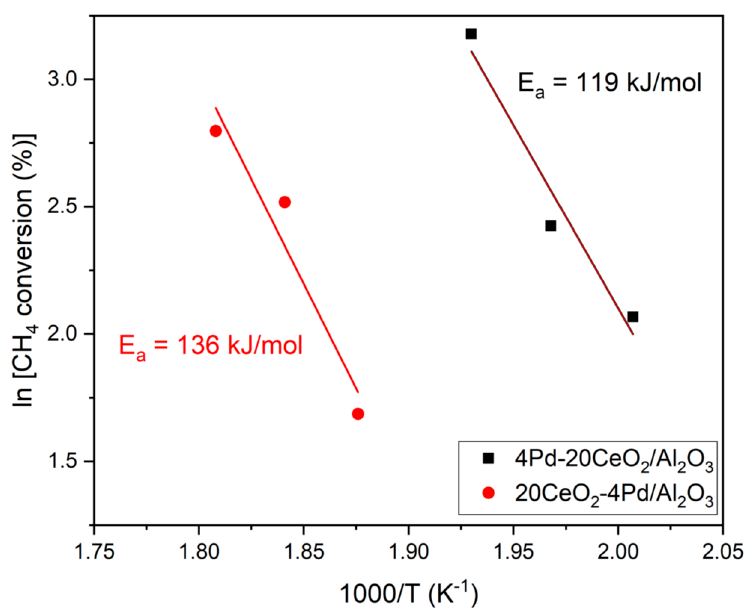
Figure 11. Activation energy for methane combustion with the two